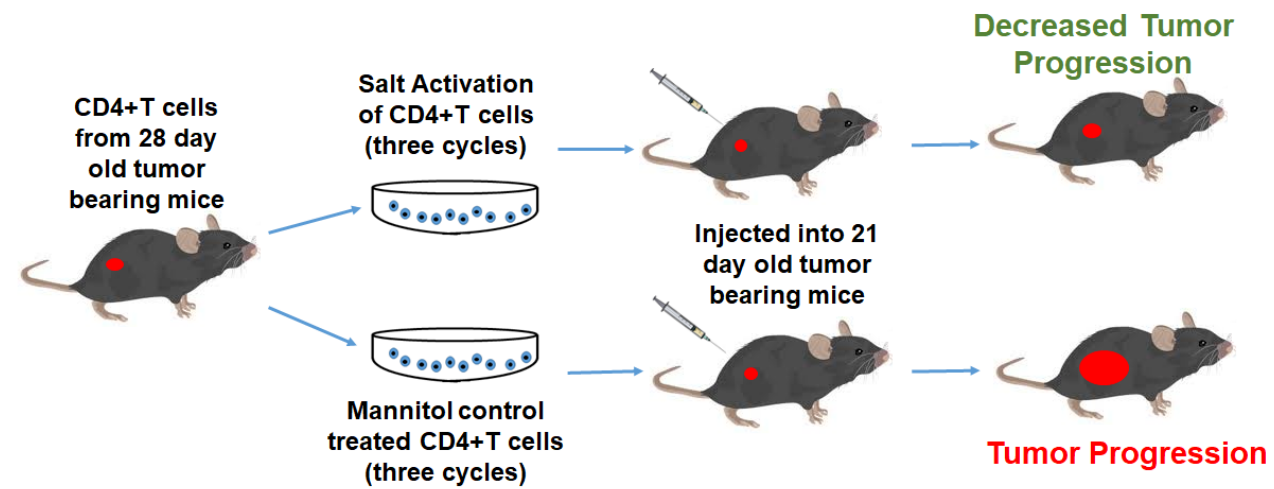
Figure 9. Schematic of the ex vivo high salt expansion of CD4+T cells. To specifically induce the expansion of the effector phenotype of CD4+T cells, we have utilized NaCl (salt), a known inflammatory molecule, for ex vivo treatment. As noted above, a major challenge with ex vivo expansion is tumor-specificity. We have observed that CD4+T cells obtained from DLNs and splenocytes demonstrated the highest anti-can- cer response. However, CD4+T cells from non-tumor-primed spleens produced a dimin- ished anti-cancer cell cytotoxicity. To maintain the tumor specificity, we have added heat killed syngeneic cancer cells in our culture during ex vivo expansion. Previous studies by Gerriets et al . [30,48] have demonstrated that the effector phenotypic switch of CD4+T cells is associated with a higher rate of glycolytic activity with relatively higher levels of basal mitochondrial activity. Our current studies are in agreement with these findings, in that tumor-primed CD4+T cells following high salt activation demonstrated a three times higher level of glycolytic reserve and 1.8 times higher basal mitochondrial oxidation, as compared to equimolar mannitol control stimulation. However, the apparent reserve mi- tochondrial respiratory capacity was higher in mannitol control treated CD4+T cells, thus suggesting that high salt treatment makes CD4+T cells utilize a higher basal mitochondrial oxidation. These data suggest that these specific changes in glycolytic and mitochondrial metabolic functionality following high salt treatment allow CD4+T cells to produce ana- bolic macromolecules such as inflammatory cytokines and cytotoxic granular needed for